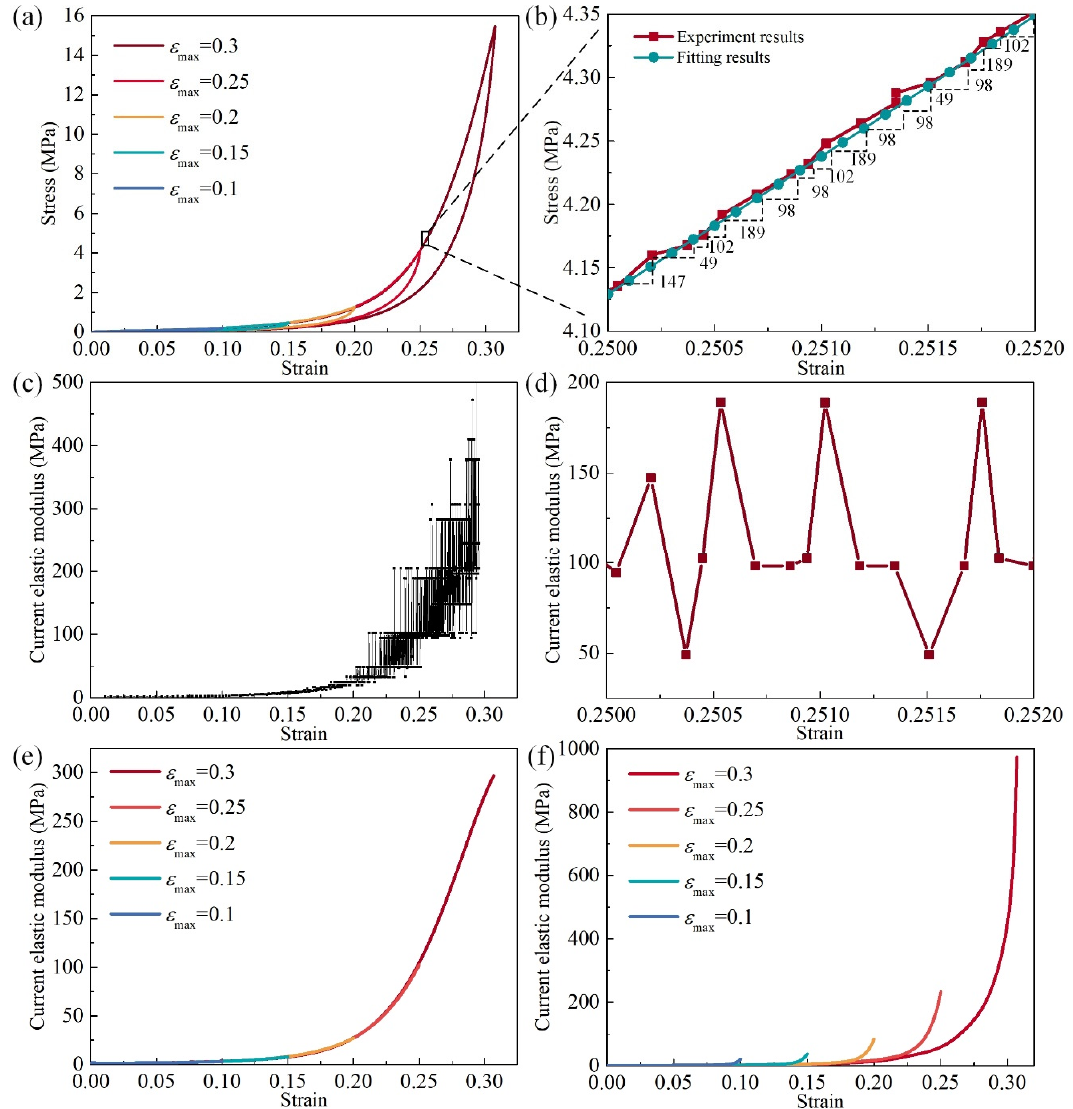
Figure 6. Current elastic modulus of MR: ( a ) stress–strain property of different maximum loading strains, ( b ) enlargement of stress–strain curve ( a ) and slope of each strain point, ( c ) elastic modulus of the experimental stress–strain results, ( d ) enlargement of ( c ), ( e ) smoothed elastic modulus of loading stage with different maximum strain, ( f ) smoothed elastic modulus of the unloading stage with different maximum strain.